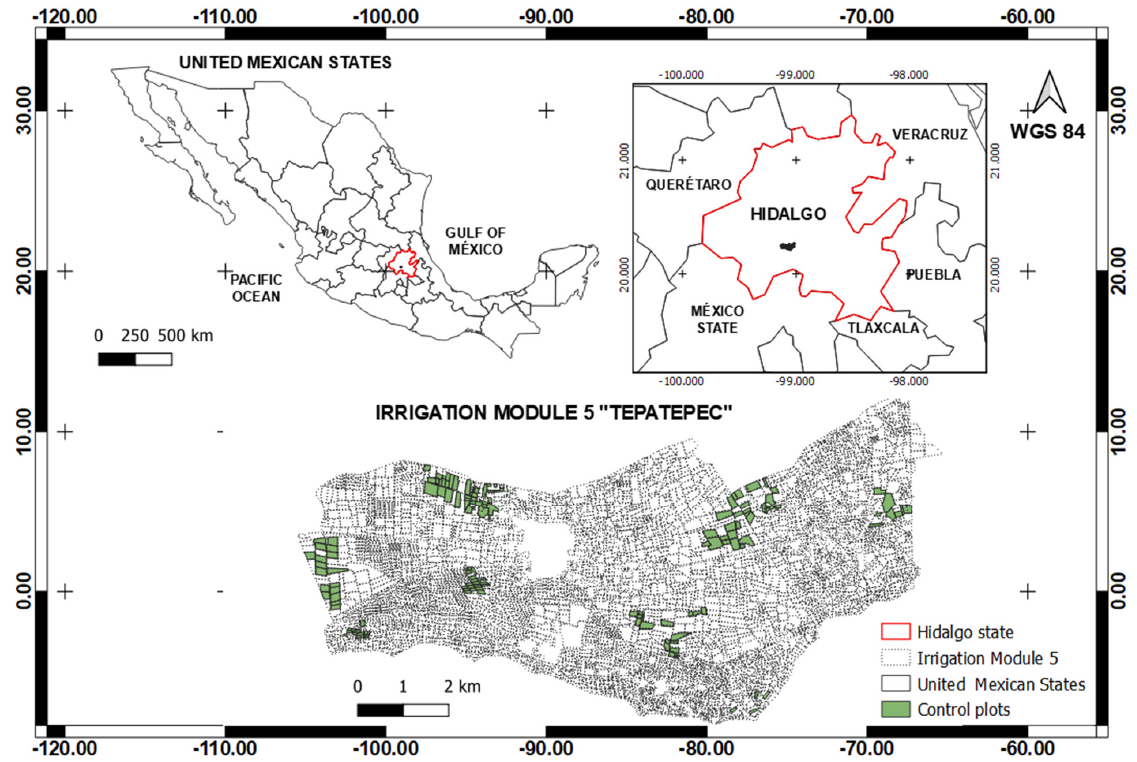
Figure 1. Localization of the study area.